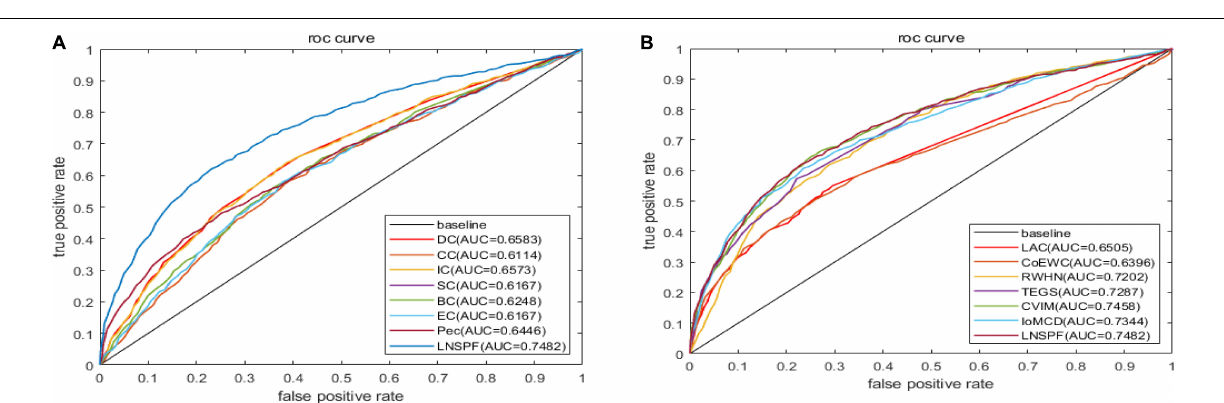
FIGURE 5 | The ROC curves of LNSPF method based on Krogan dataset and DC, CC, IC, SC, BC, EC, PEC, and LAC, CoEWC, RWHN, TEGS, CVIM, and IOMCD 13 prediction methods. (A) Comparison between LNSPF and DC, CC, IC, SC, BC, EC, PEC. (B) Comparison between LNSPF and LAC, CoEWC, RWHN, TEGS, CVIM, IOMCD.